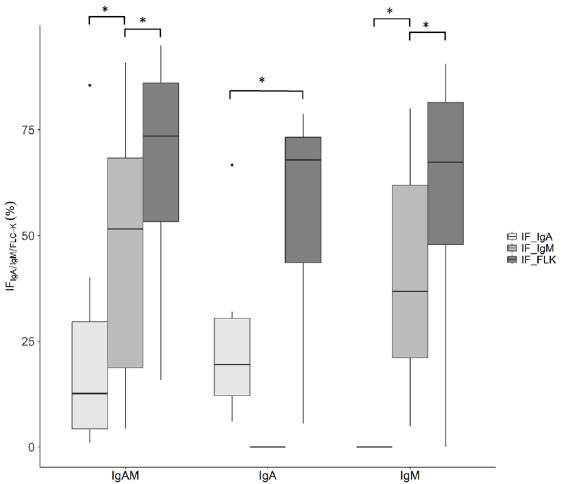
Figure 2. Boxplot of the IF IgA/IgM/FLC-k of cohort 1. Cohort I is divided into isolated IgA and combined IgA and IgM synthesis in the quotient diagram. In both cohorts, differences between IF IgA, IF IgM, and IF FLC-k were significant. * p -value < 0.05 (from left to right: p = 0.0001, p = 0.08, p = 0.01, p < 0.001, and p = 0.006). IF = intrathecal